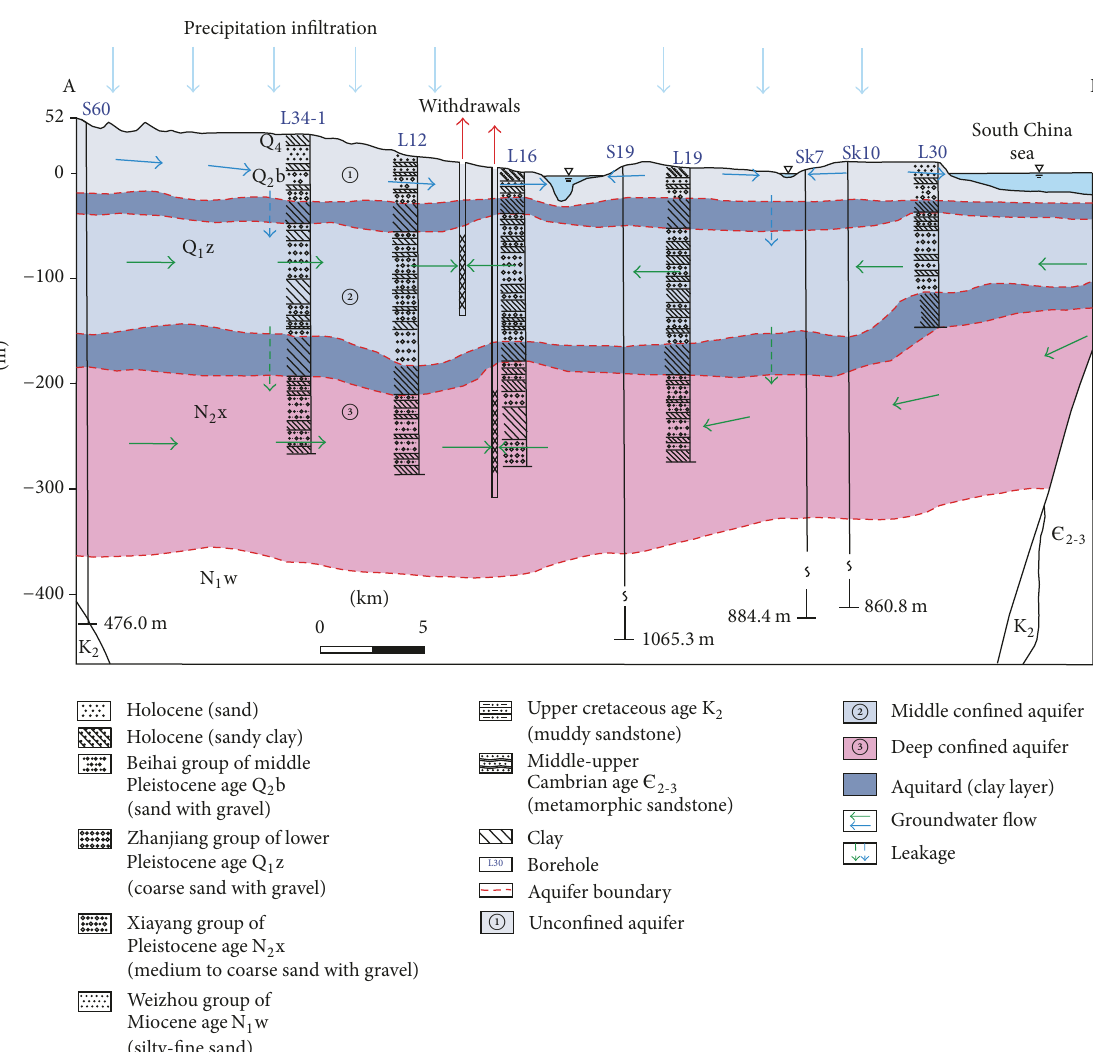
Figure 2: Hydrogeological cross-section (Line A-B in Figure 1) of the study